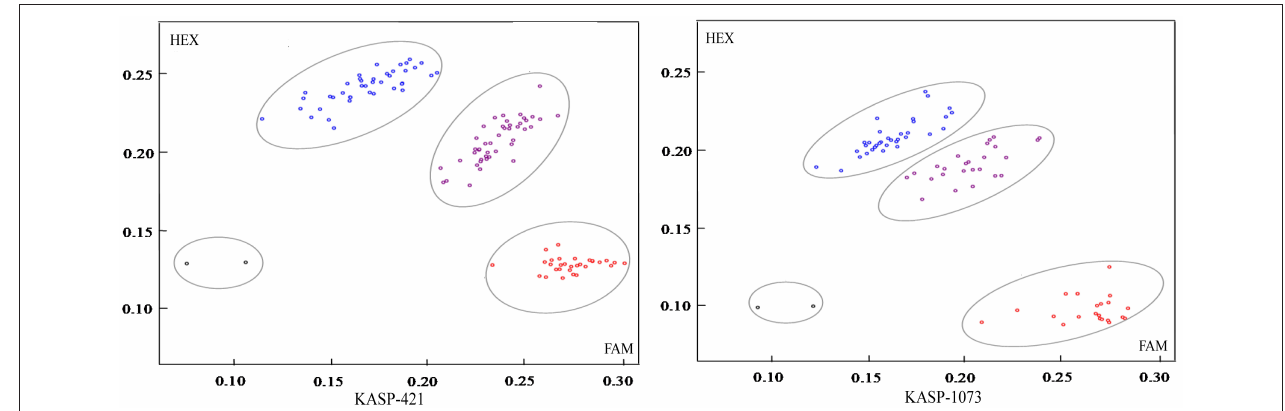
FIGURE 4 | KASP marker genotyping in a segregating Brassica napus F 2 population using functional markers KASP421 and KASP 1073 for high oleic acid content. The red circle represents homozygous alleles derived from parent line “E183” with normal oleic acid content, the blue circle represents homozygous alleles derived from parent line “FC81” with high oleic acid content, and the purple circle represents heterozygous loci. The black circle represents negative control.